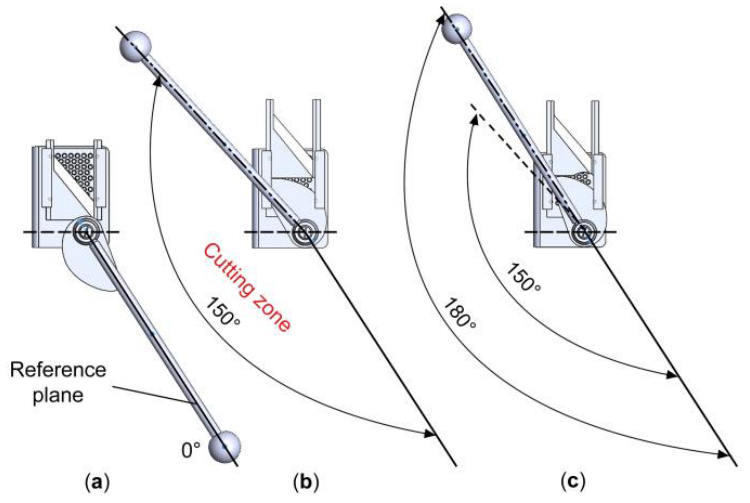
Figure 15. Rotation angles of the cutter crank at the new knife: ( a ) rotation angle 0°; ( b ) “ cutting ” ; ( c ) rotation angle 180°.